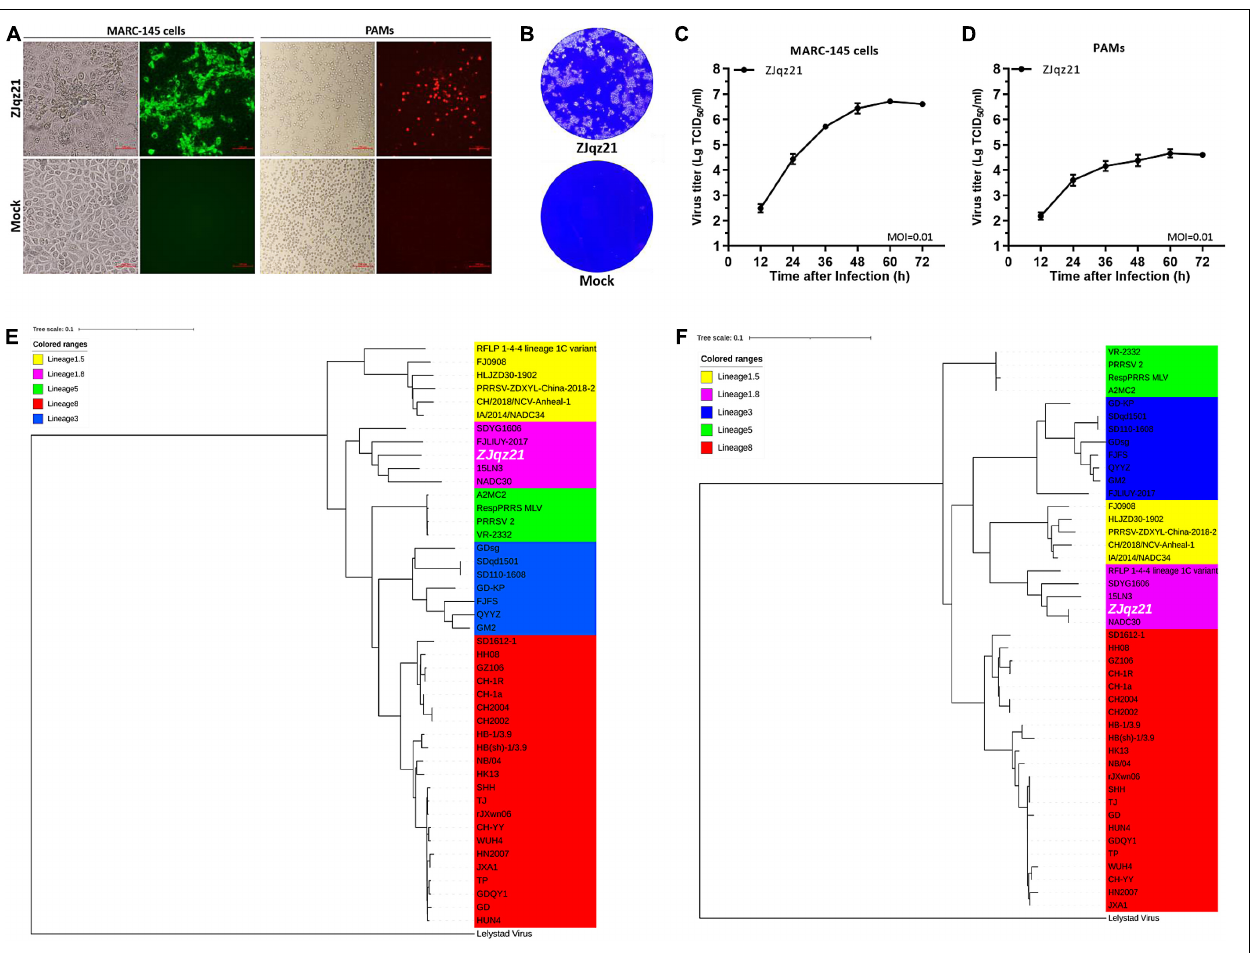
FIGURE 1 | (A) Cytopathic effects (CPE) and immunofluorescence staining against the N protein in Primary porcine alveolar macrophages (PAMs) and MARC-145 cells at 36 hpi with ZJqz21 (MOI = 0.1). Scale bar = 100 µ m. (B) Plaque morphology. MARC-145 cells were infected with ZJqz21 (MOI = 0.001). The mock control represented non-infected MARC-145 cells. The MARC-145 cells were stained with crystal violet at 5 days post-infection. Virus growth kinetics in MARC-145 cells (C) and PAMs (D) . Data represent the mean ± standard deviation (SD) of three independent experiments. Phylogenetic trees of ZJqz21 based on the complete genome (E) and GP5 (F) nucleotide sequences. A white color highlighted the ZJqz21 strain. The scale bar indicated the number of nucleotide substitutions per